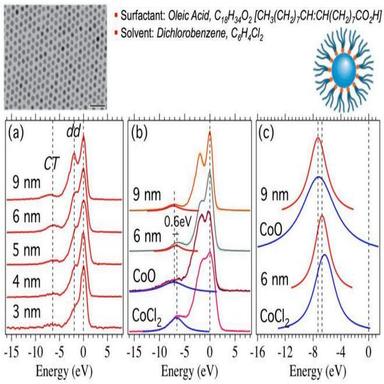
RIXS spectra of cobalt nanocrystal suspensions (a) peak fittings of RIXS spectra of cobalt nanocrystal and reference cobalt compounds (b) charge transfer peak of cobalt nanocrystal and cobalt reference compounds (c). .